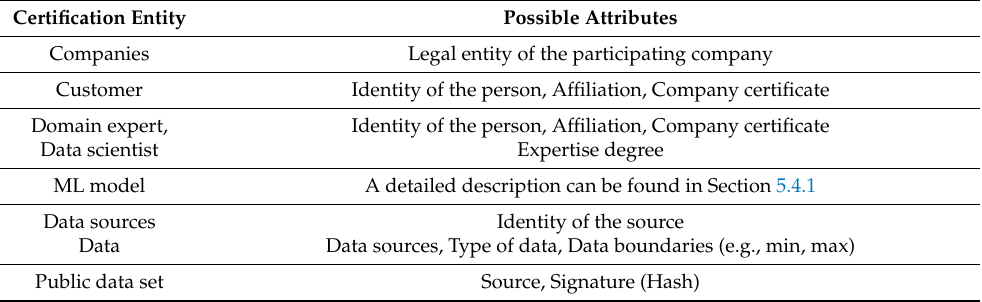
Table 9. Certification entities and their possible